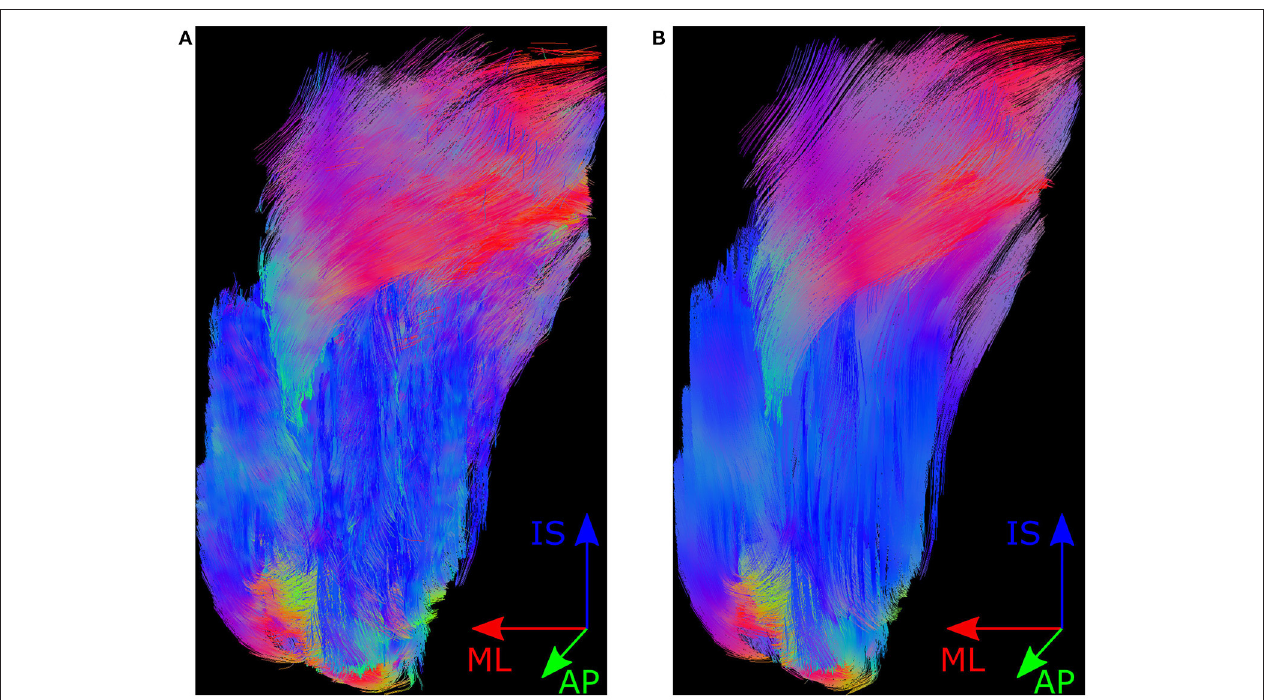
FIGURE 2 | Muscle fibres in MedINRIA. Shown here is the posterior view of the muscle fibre tracts produced by MedINRIA’s DTI Track module. Panel (A) shows the fibres produced when using the raw NIfTI images as input, and the fibres shown in (B) are produced from the de-noised NIfTI images. The colours in fibre tracts indicate the anatomical axis along which they are aligned, i.e., the inferior-superior direction is represented by blue, the medial-lateral axis by red, and the anterior-posterior direction by